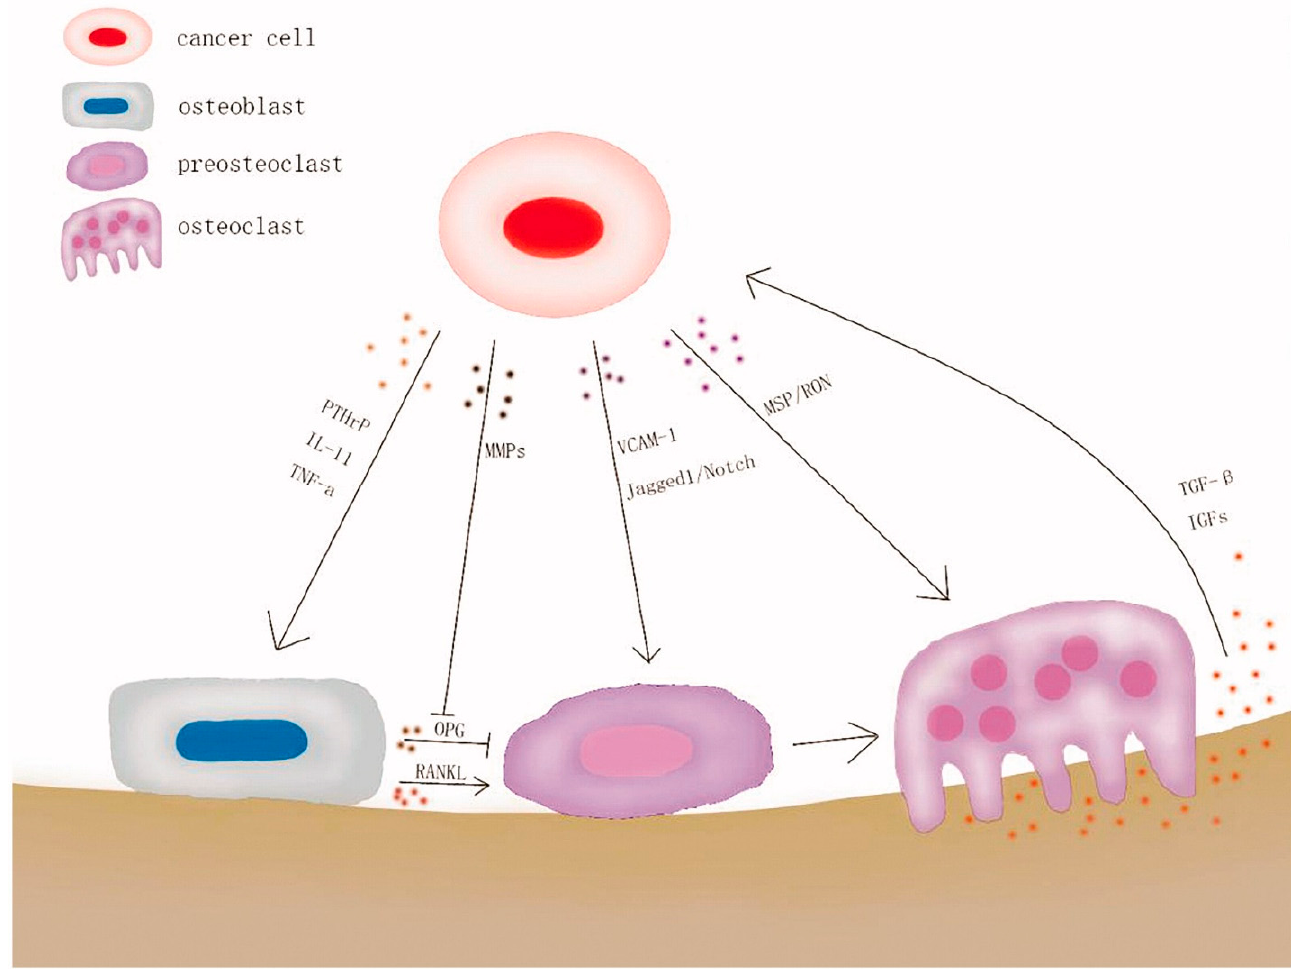
Figure 3. Graphical representation of the “vicious cycle” caused by cancer bone metastasis. Reprinted from an open-access source [36].